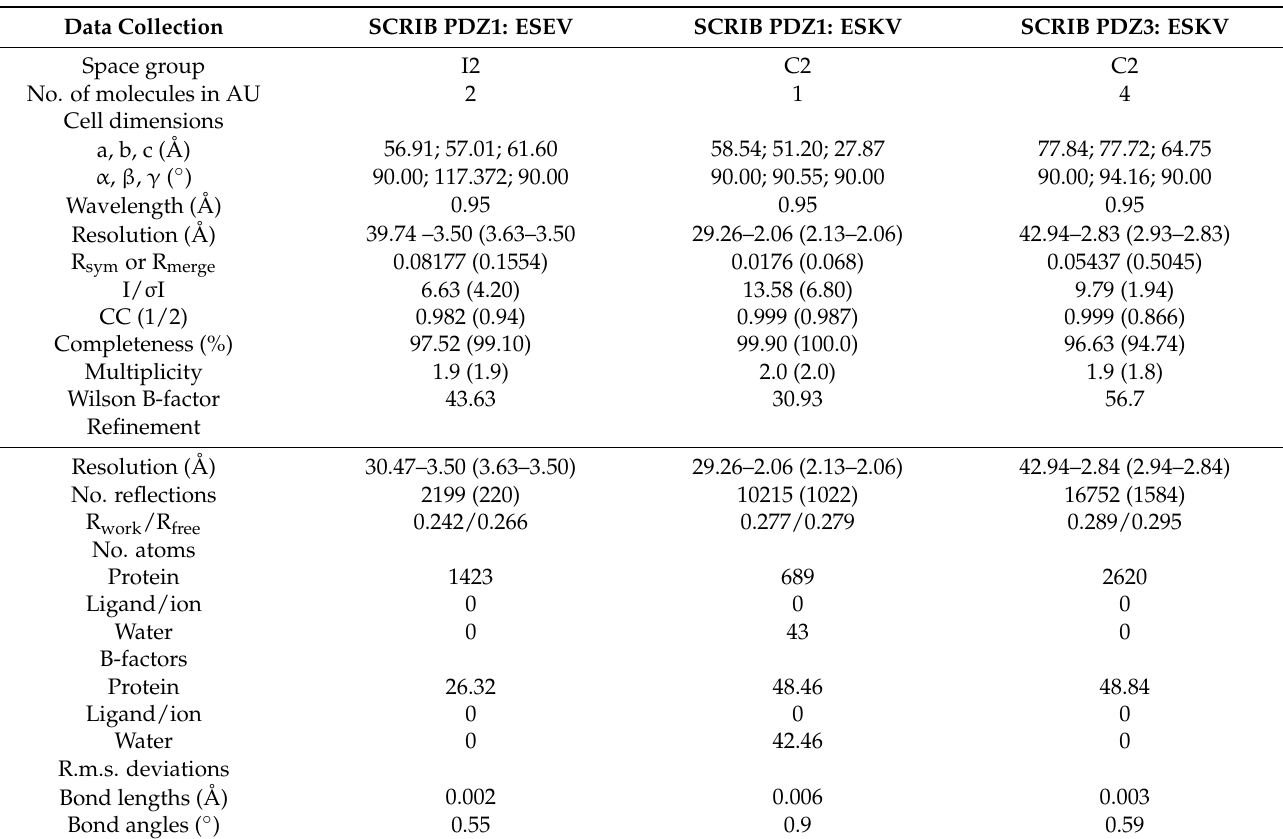
Table 3. X-ray crystallographic data collection and refinement statistics. Values in parentheses are for the highest resolution